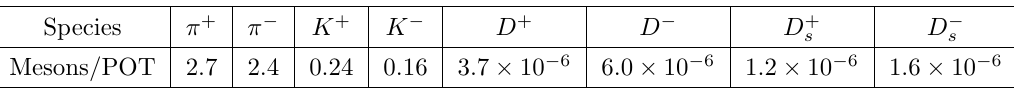
Table 4 . Average number of charged mesons produced per proton-on-target assuming 120 GeV protons.